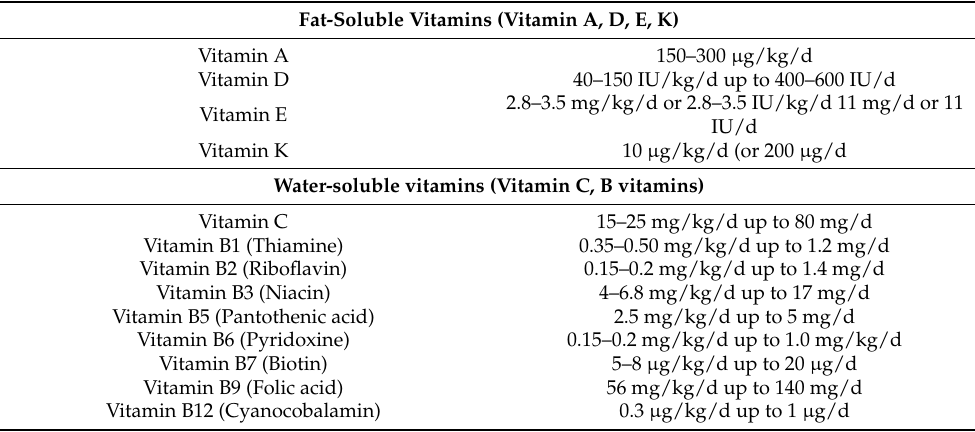
Table 4. Recommended dosing of vitamins and trace elements by the European Society of Clinical Nutrition and Metabolism